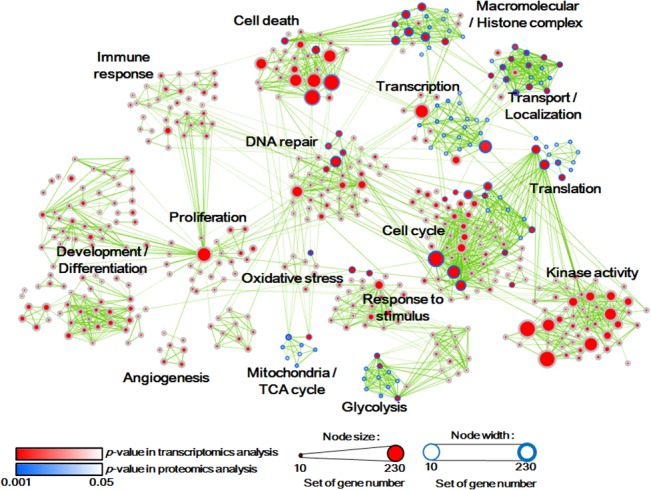
Functional analysis to visualize transcriptomic and proteomic data.Significantly altered genes in HK-2 cells following cisplatin treatment as detected by microarray analysis (transcriptomic) and liquid chromatography coupled with tandem mass spectrometry (LC-MS/MS) (proteomic). Functional analysis of data was performed using the Database for Annotation, Visualization, and Integrated Discovery (DAVID). Results were visualized using the enrichment map plug-in for Cytoscape. Each circular node is a gene set with a diameter proportional to the number of genes. The inner node color represents the p-value of the enrichment analysis in the transcriptome, whereas the outer node color represents the p-value of the enrichment analysis in the proteome. The edge width is proportional to the similarity of gene sets between linked nodes. Details of the network can be examined using the scalable PDF in S1 Fig.